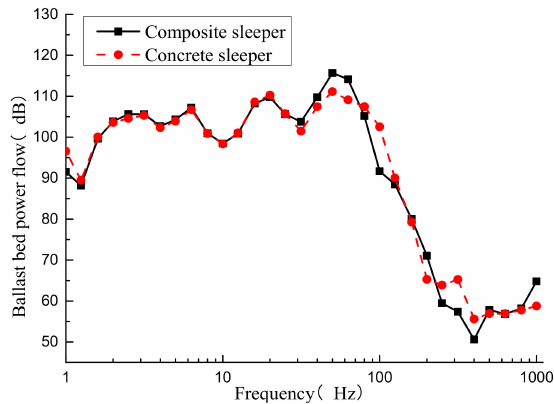
Figure 11. Ballast bed power